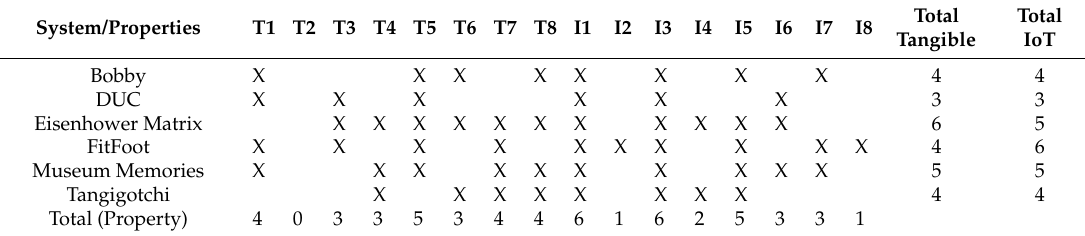
Table 2. Property explored by each system at least in a phase of the workshop.